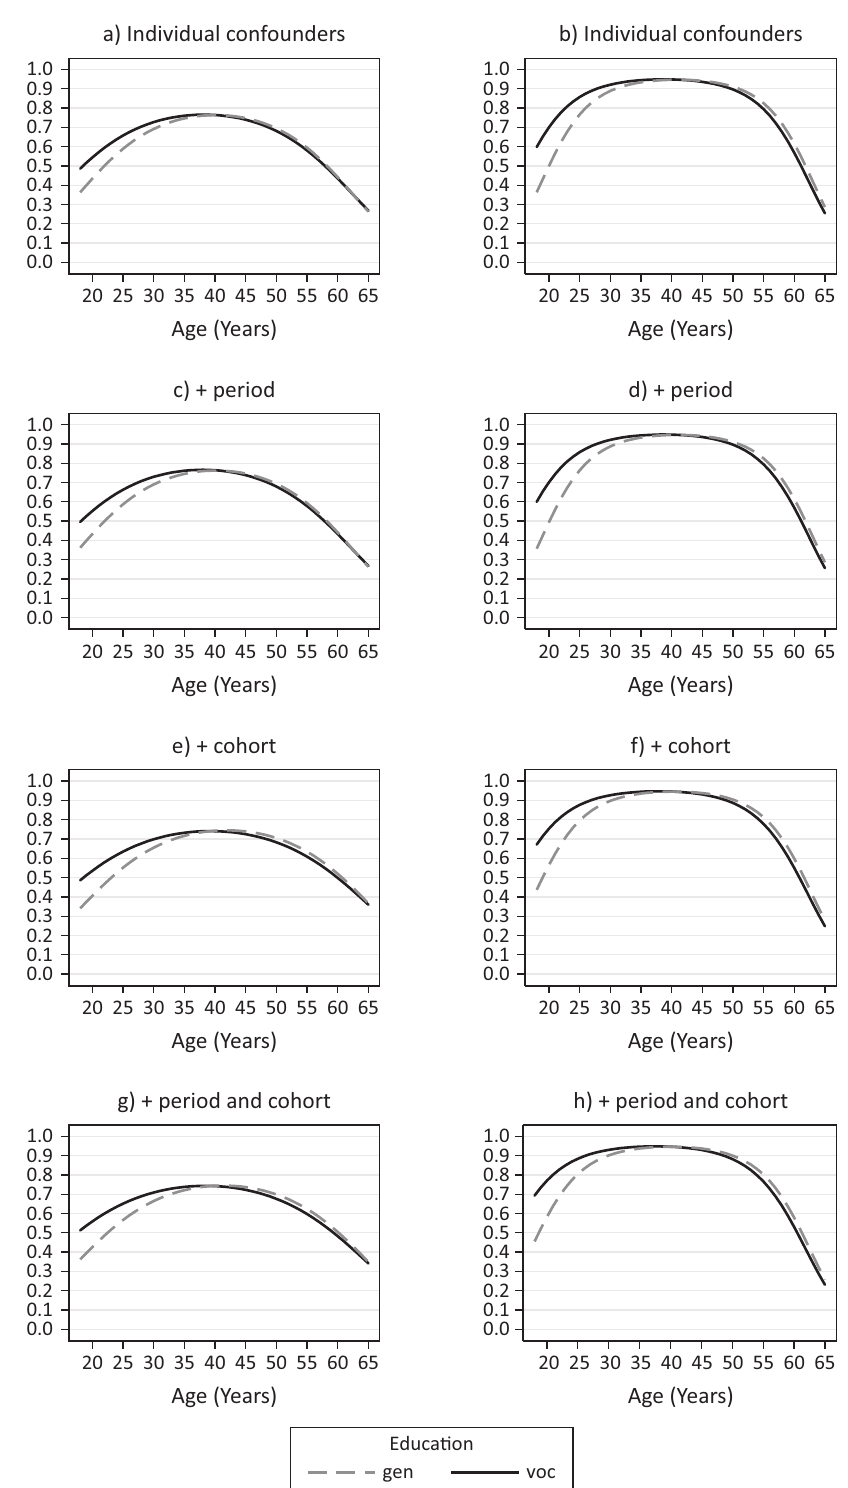
Figure A2. The importance of period and cohort effects for age trajectories for women (left) and men (right). Employment opportunity over the life course: General versus vocational education by gender. Note: Conditional profile plots for women (left) and men (right). Control variables include period effects, cohort effects, German nationality, parental educational background, residence in West Germany, and educational level. N persons = 44,502; N person-years = 332,537. Detailed regression results available upon request. Data source: GSOEP